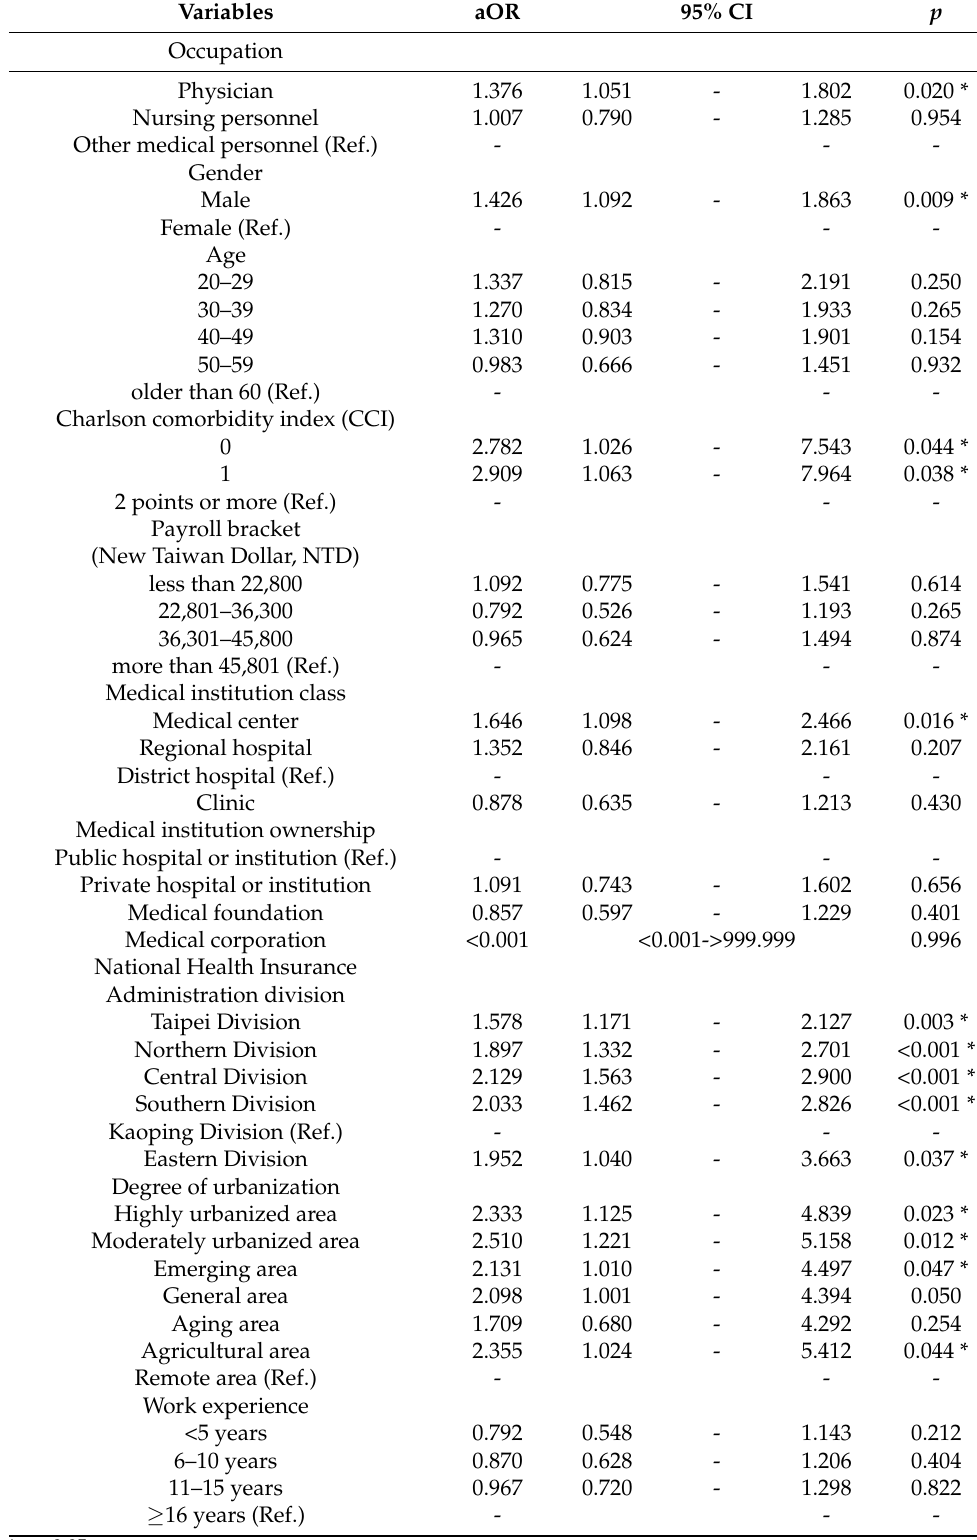
Table 4. Multivariable Analysis of Associations Between medical providers and infectious and parasitic disease (N =